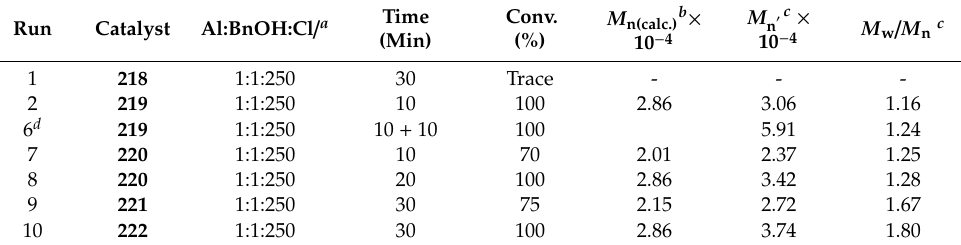
Table 8. ROP of ε -CL catalyzed by dinuclear complexes 218–222 [113].